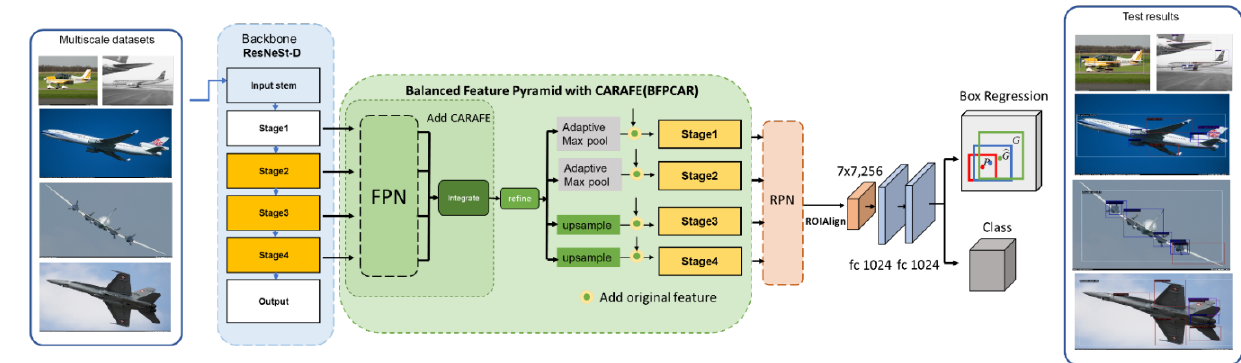
Figure 3. Multi-scale information augmentation framework (Contains ResNeSt-D and BFPCAR based on Faster R-CNN).